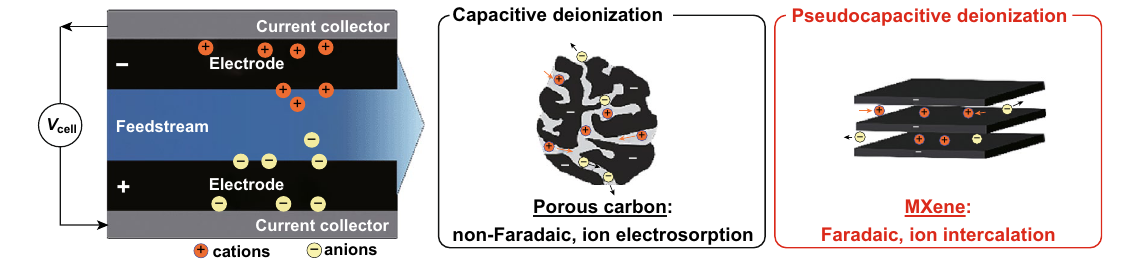
Fig. 10 Concept of electrochemical water desalination by non-faradaic (electrostatic) ion electrosorption at the surface of electrode materials. Reprinted with permission from Ref. [39]. Copyright © (2019) Royal Society of